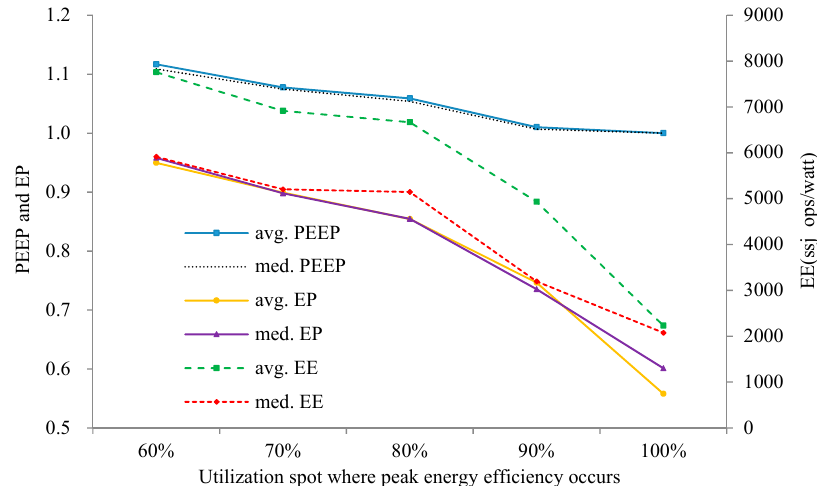
Figure 6. PEEP, EP, and EE with respect to utilization where peak energy efficiency occurs.